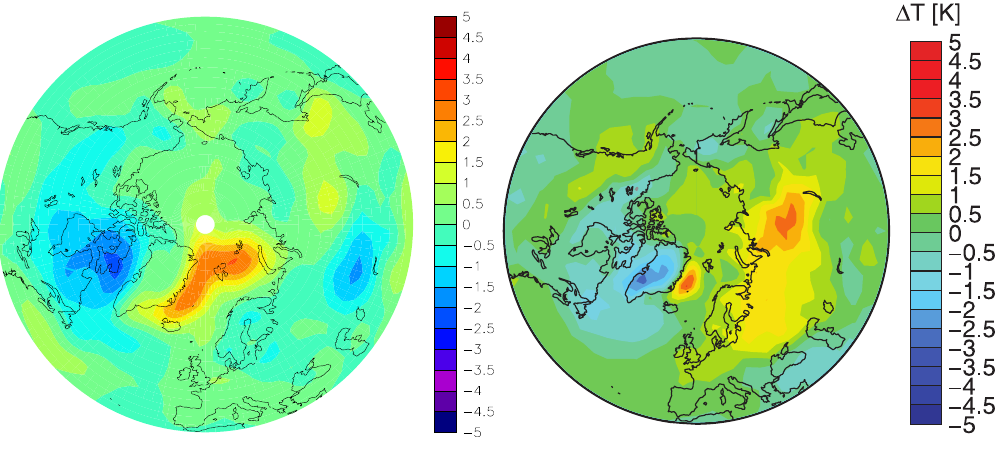
Fig. 1. Left: Northern Hemisphere DJF surface temperature difference between years of high and low geomagnetic activity (see Table 1). Left: transient simulation (S-TRANSIENT), right: from ERA-40 reanalysis data, taken from (Sepp ¨ al ¨ a et al., 2009, their Fig. 2). Red/blue colours indicate positive/negative differences.